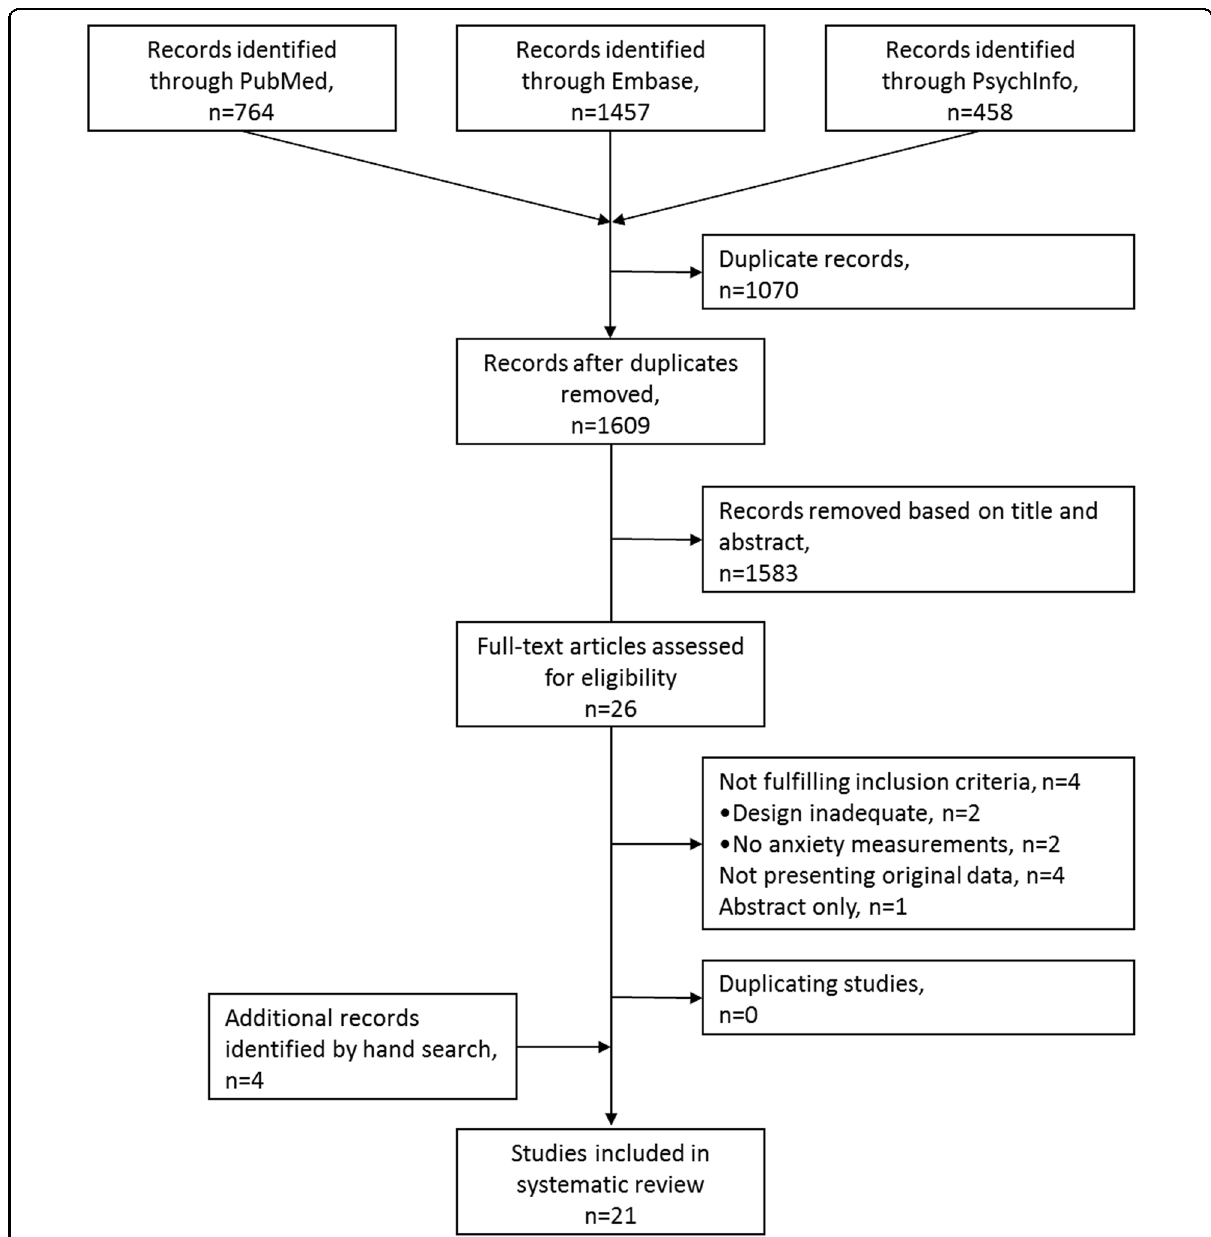
Fig. 1 Flowchart of the literature